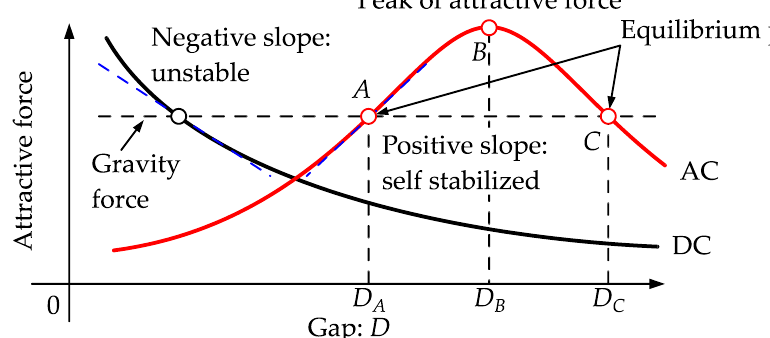
Figure 6. Schematic view of attractive force with respect to the gap. A black line represents the characteristic of a conventional DC magnetic suspension system with a constant current. A red line represents the characteristic of AC magnetic suspension. A horizontal black dashed line represent gravity force due to the mass of the floator. The black circle indicates the equilibrium point of force in the DC magnetic suspension. The red circle A represents an equilibrium point of the attractive force and the gravity in the range of positive stiffness. The red circle B represents the peak of attractive force. The red circle C represents an equilibrium point of the attractive force and the gravity in the range of negative stiffness. The gap corresponding to the point α is expressed as D α ( α = A , B , C ).